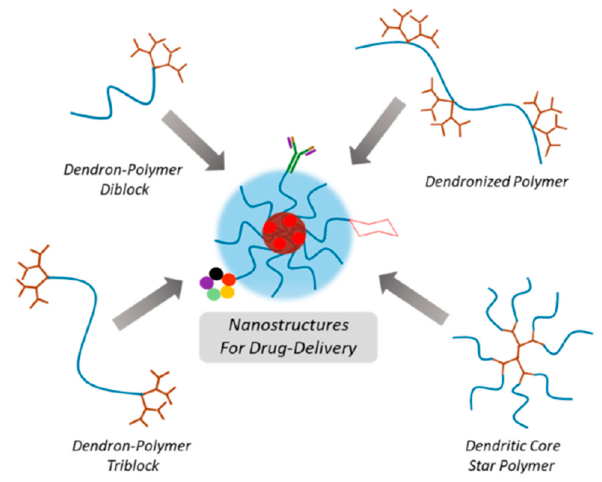
Figure 39. Overview of various linear-dendritic architectural copolymers that undergo supramolecular assembly to form a broad diversity of nanoscale drug delivery vehicles [113].